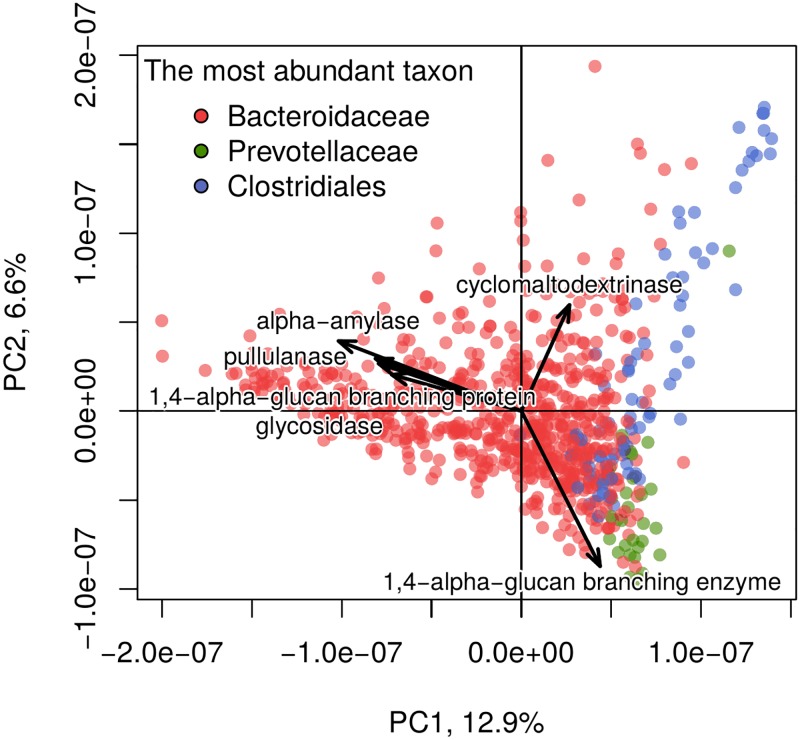
Distribution of the metagenomes by the abundance of the genes associated with starch degradation.On the PCA plot, for each sample, the color shows the most abundant taxon. The color legend represents the three major taxa (the Bacteroidaceae and Prevotellaceae families and the Clostridiales order). The latter taxon was taken at a higher level of phylogenetic hierarchy because it includes multiple starch-degrading families (i.e., Eubacteriaceae and Ruminococcaceae), which together contribute to the observed gradient without a clear single driver. The percent of total variance explained by each of the first two principal components is included in the respective axes labels.